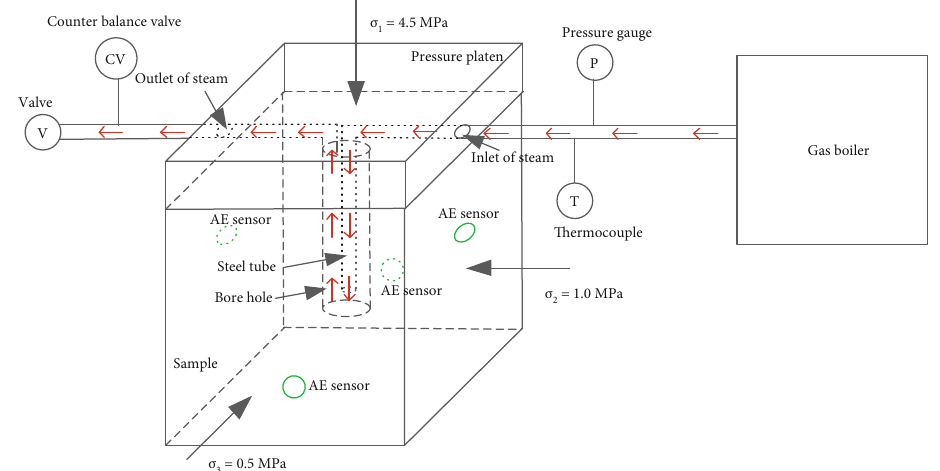
Figure 3: Schematic diagram of the experimental setup.